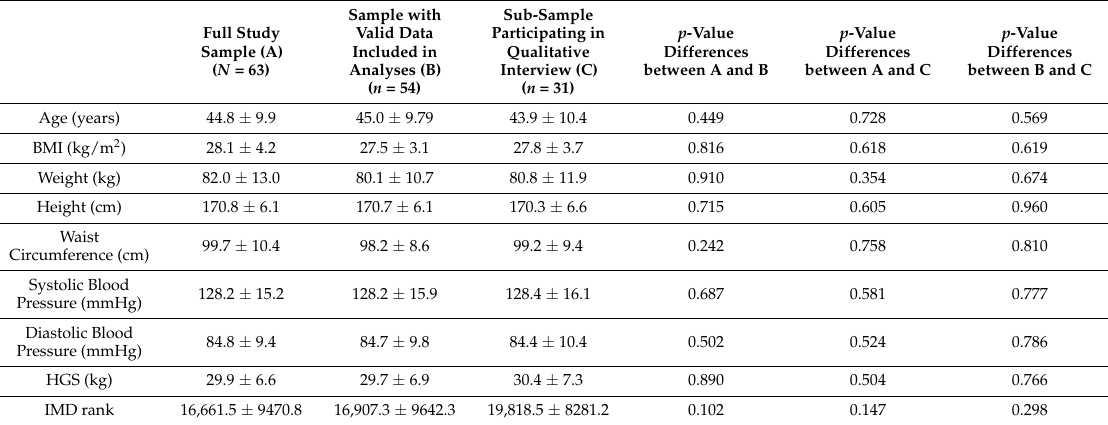
Table 1. Anthropometric characteristics, resting blood pressure, handgrip strength, and index of multiple deprivation data for 63 South Asian men participating in the study.